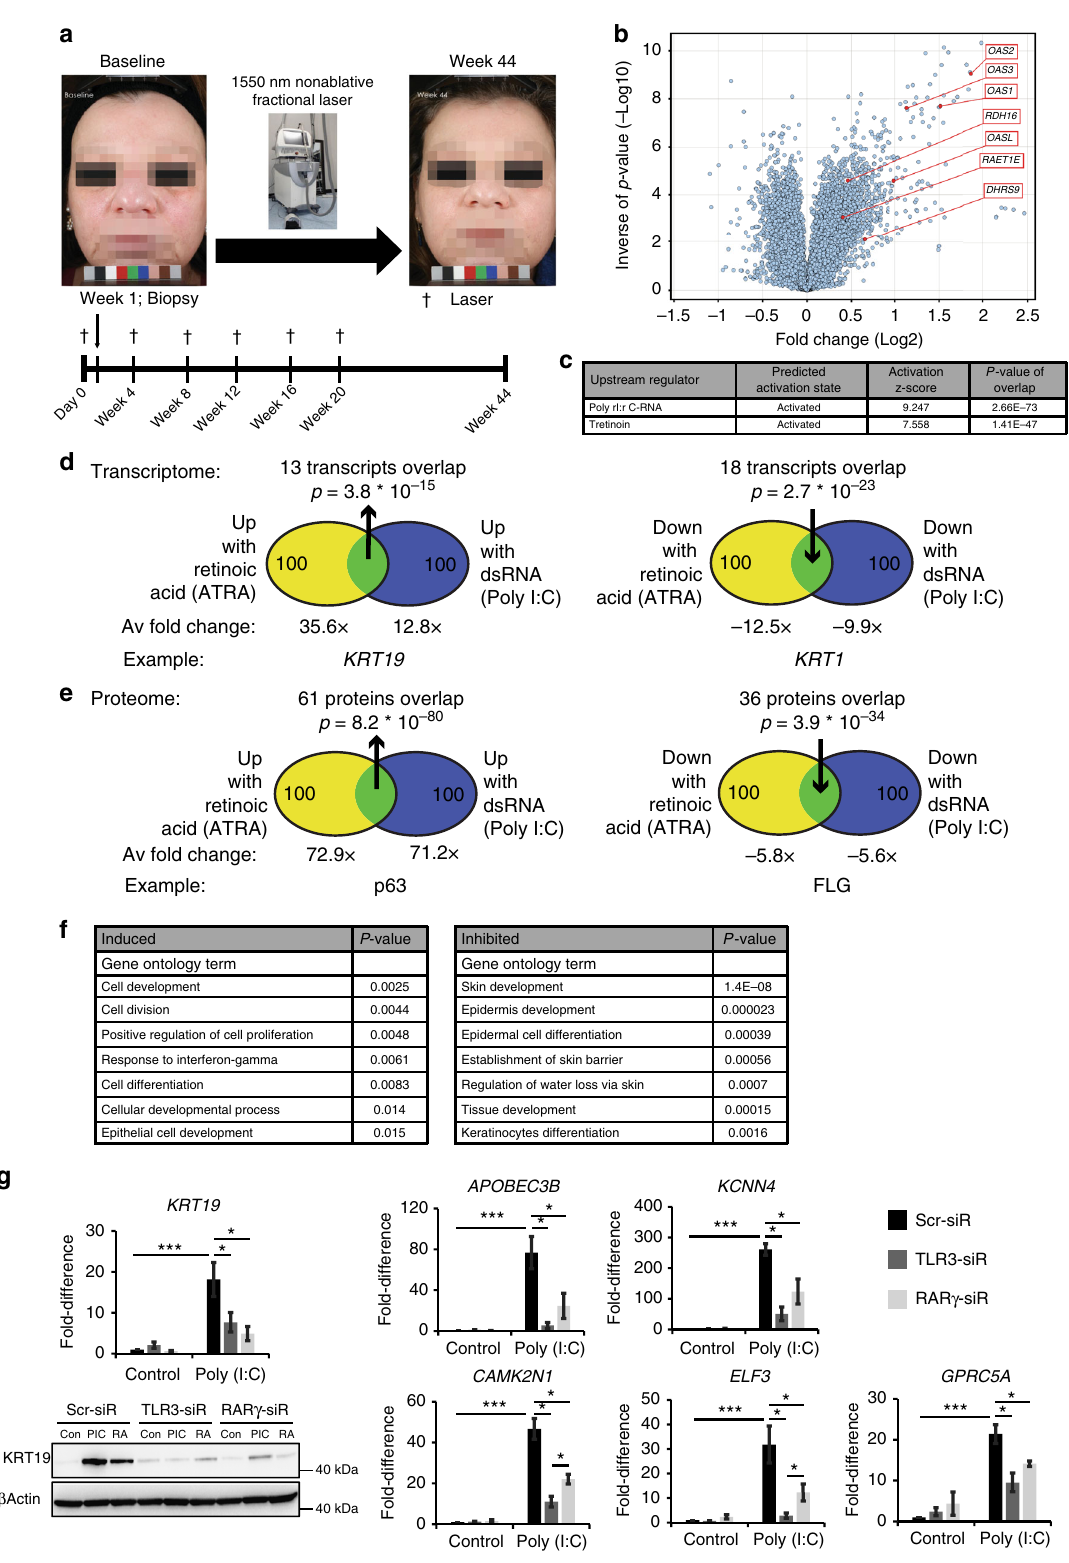
follicle formation (WIHN) (Fig. 2a), whereas Tlr3 − / − mice show limited regeneration capacity compared to wild-type (WT) mice (Fig. 2g). Given that Poly (I:C) induces intrinsic RA synthesis, we speculated that Tlr3 − / − mice might have lower RA abundance. We fi rst measured endogenous RA levels using